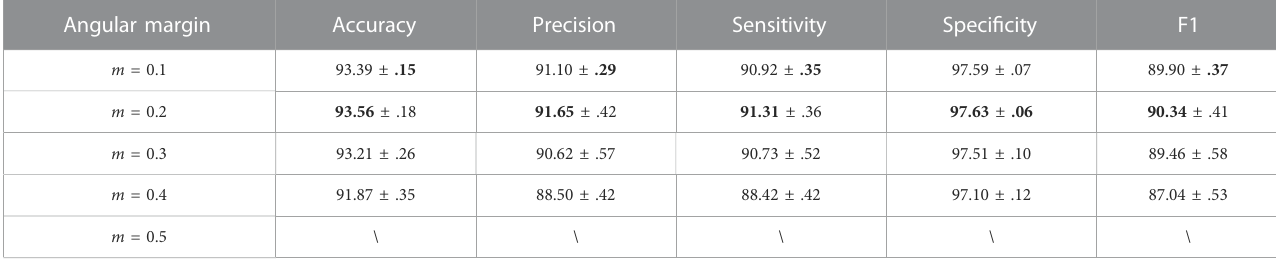
TABLE 5 The table below shows SupCAM performance with different angular margin values ( m in Eq. 7) used in the self -margin loss during the fi rst pre-training step.